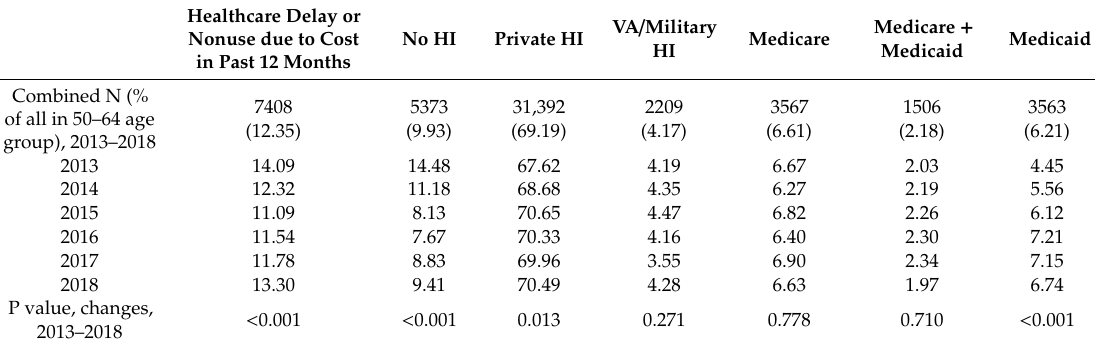
Table 2. The 50-64 age group: Changes in healthcare access and health insurance (HI) coverage status, 2013–2018